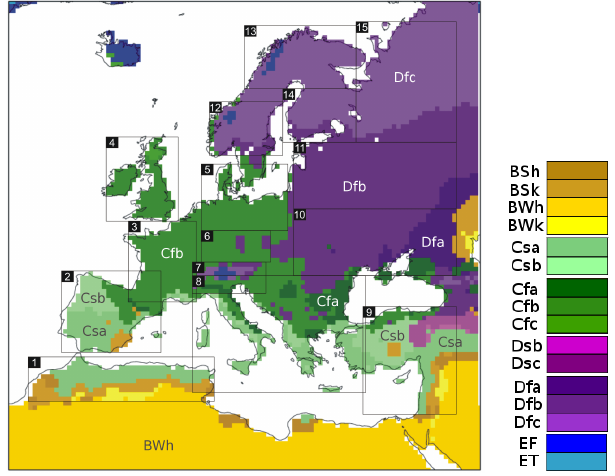
Figure 3. Climate types based on the Köppen–Geiger climate clas- Fig.3. ClimatetypesbasedontheKoeppen-Geigerclimateclassificationandevaluationregionsforthemodel domain sification and evaluation regions for the model